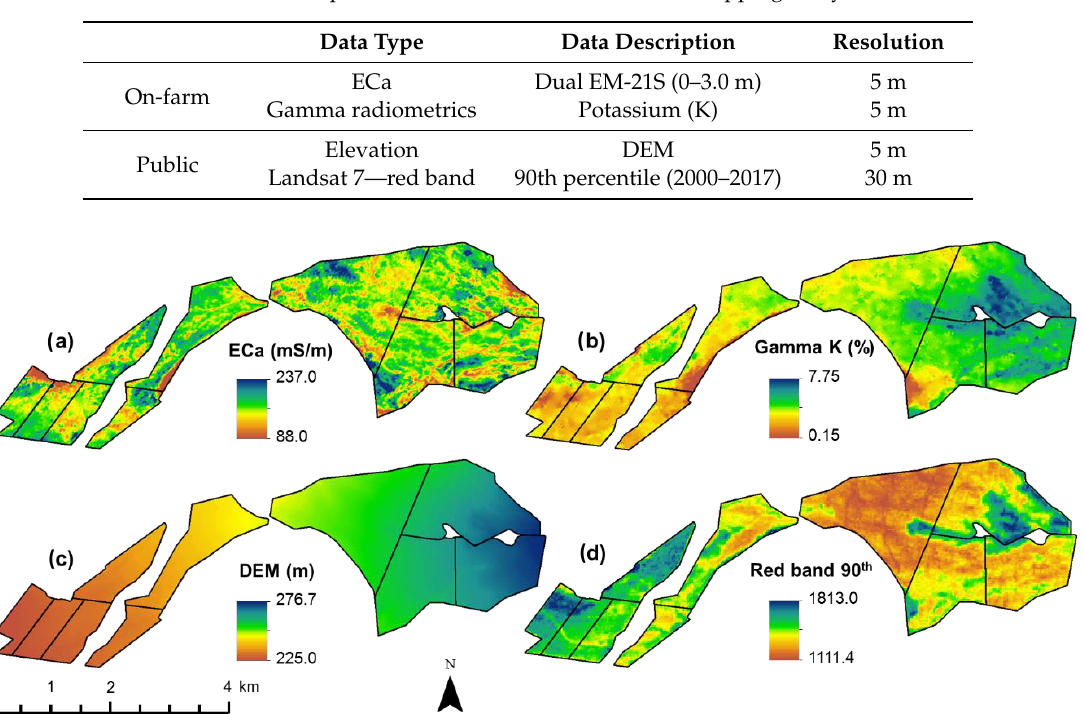
Table 1. Description of the data sources used in the mapping analysis.